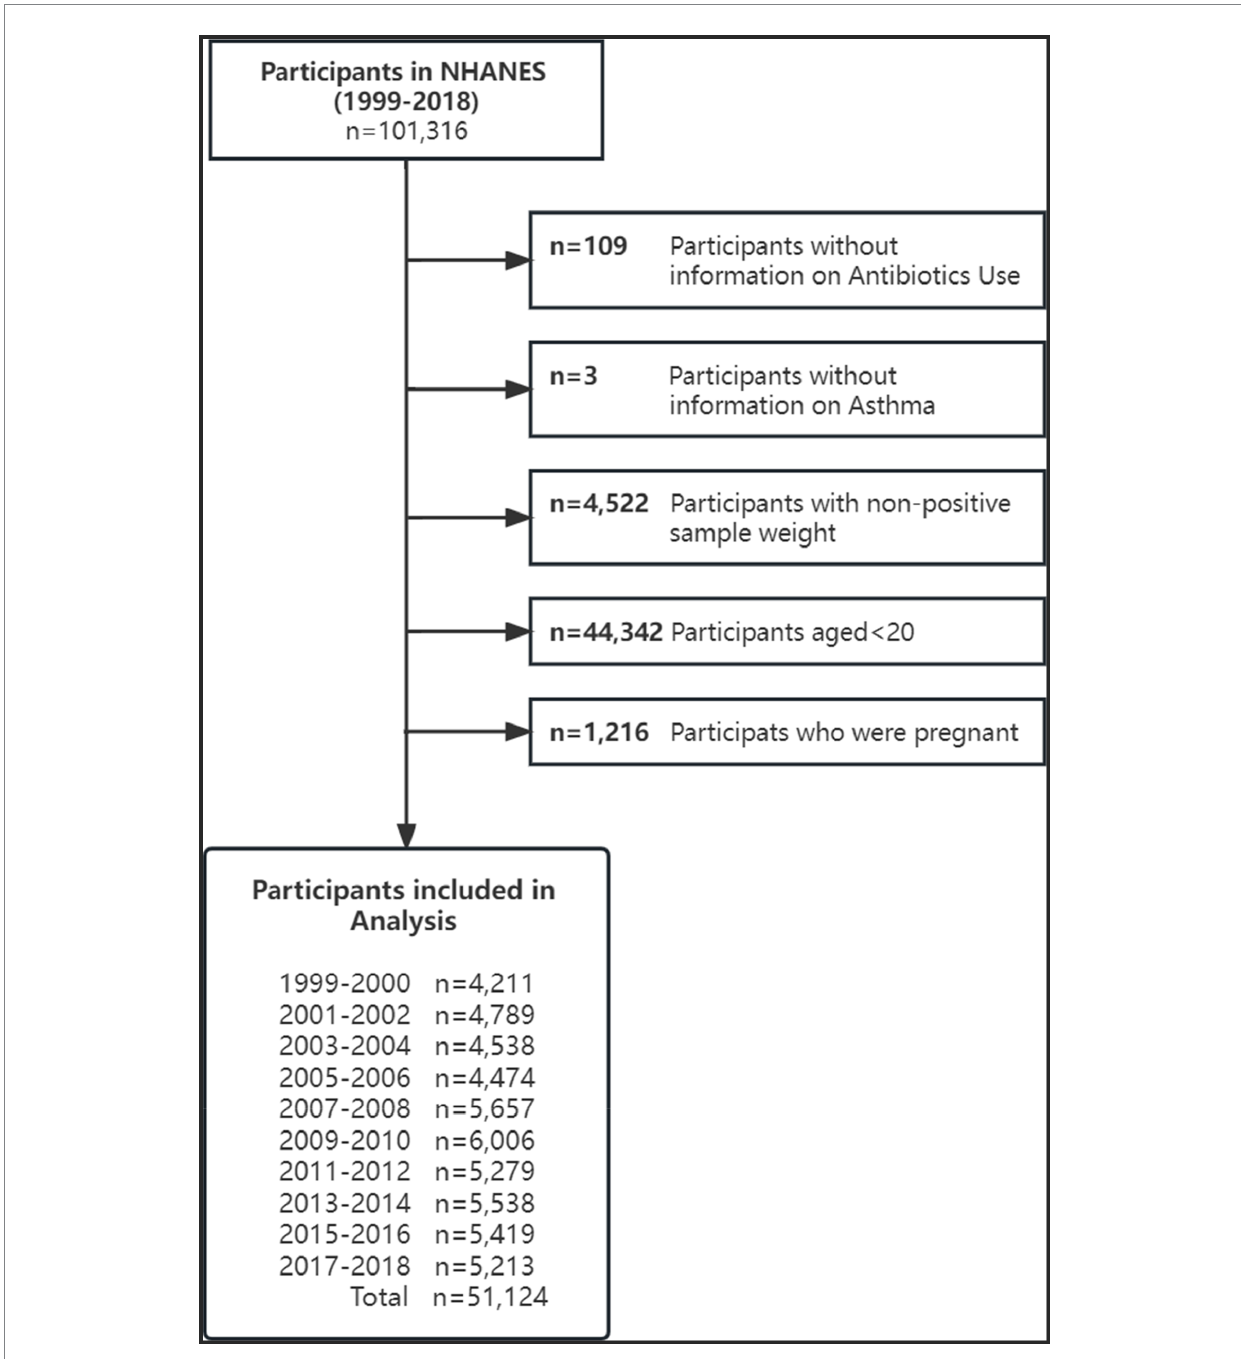
FIGURE 1 Flow diagram of included survey participants by survey year: National Health and Nutrition Examination Surveys (NHANES) from 1999 to